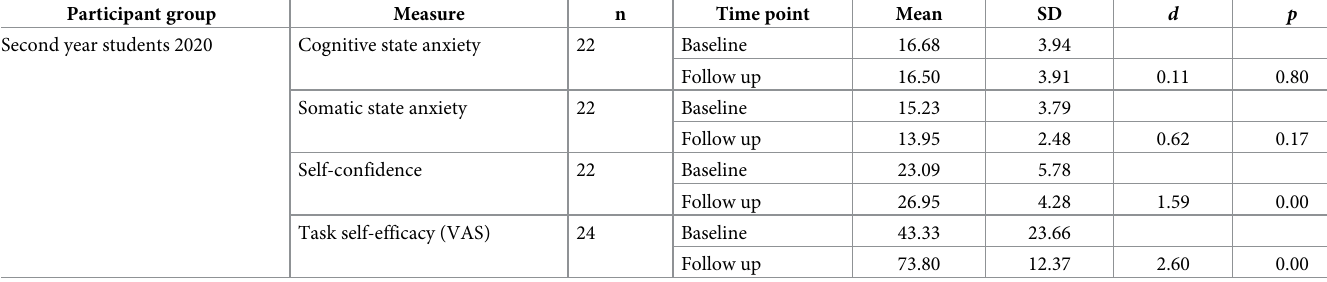
Table 3. Repeated measure study comparing anxiety and confidence (using the CSAI-2 and purpose-built questionnaire (VAS)) outcomes prior (baseline) and fol- lowing (follow up) 1-hour training and six-weeks self-paced use in second year students (2020 cohort). Participant